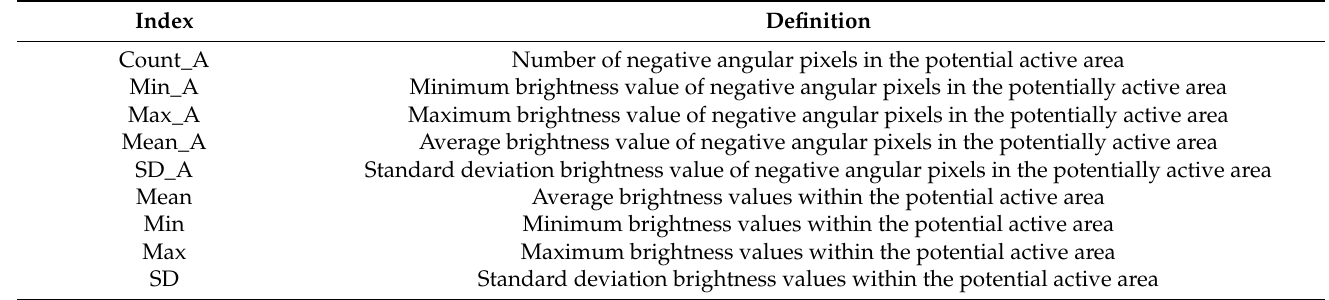
Table 4. A specific description of the nine nighttime lighting statistics indexes.